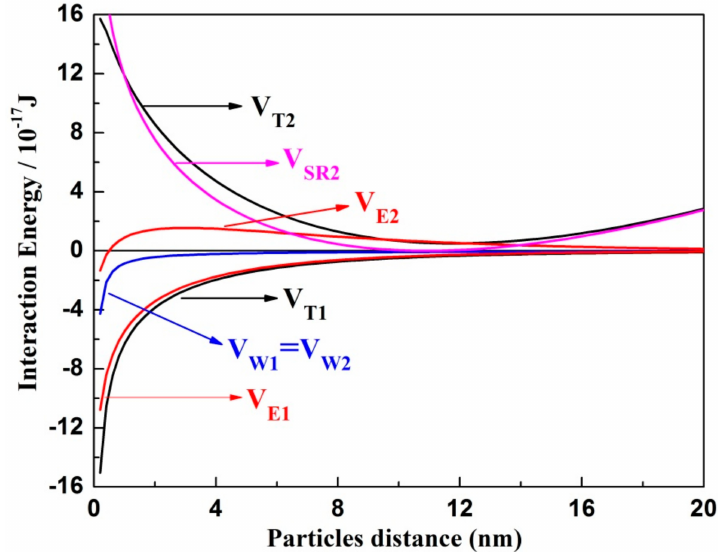
Figure 13. Interaction energy between MoS 2 and Mg(OH) 2 at pH